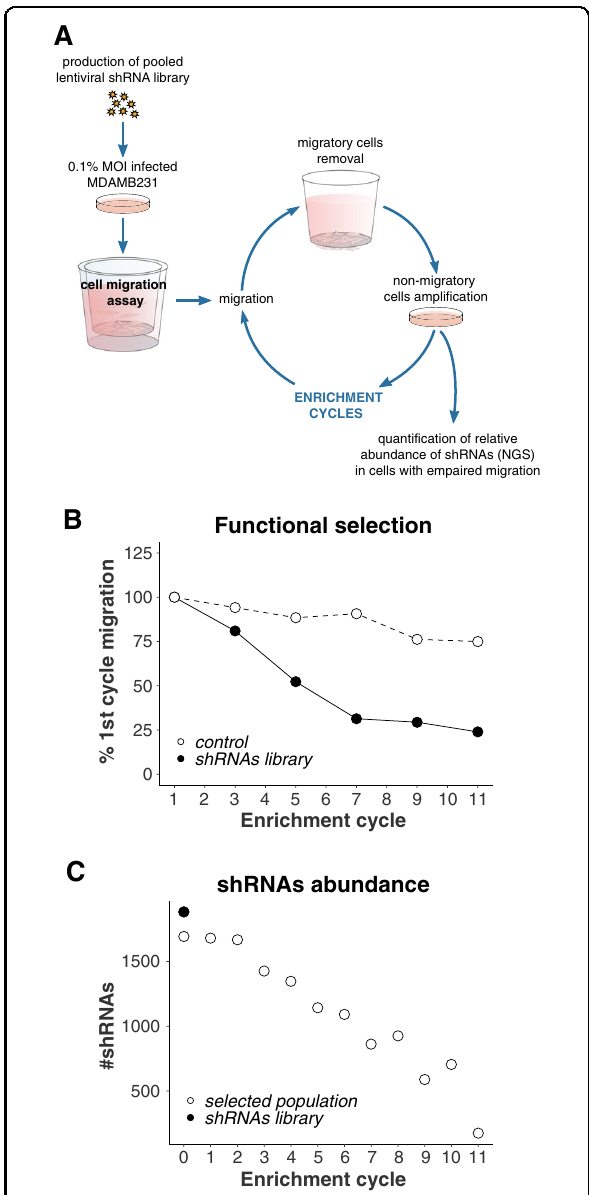
Fig. 1 shRNA-based selection of positive regulators of cell migration. A Overview of the selection procedure. The production and infection of a ubiquitination-related lentiviral shRNA library are described in Methods. Two weeks after lentiviral infection and selection, MDAMB231 cells were seeded onto transwell inserts and allowed to migrate across the porous membrane for 24 h in order to select cells with a decreased migration phenotype. Migrating cells were removed and non-migrating cells were collected from the inserts upper compartment and ampli fi ed. Cells were then reseeded onto transwell culture inserts for a subsequent cycle of selection; this procedure was repeated until cells lost 80% of their initial migratory potential. After every cycle of selection, the relative abundance of the different shRNAs was evaluated using Next-Generation Sequencing. B Transwell assay was used every other enrichment cycle to determine the percentage of migratory cells and monitor the selection process. C shRNAs ’ abundance was estimated after each selection